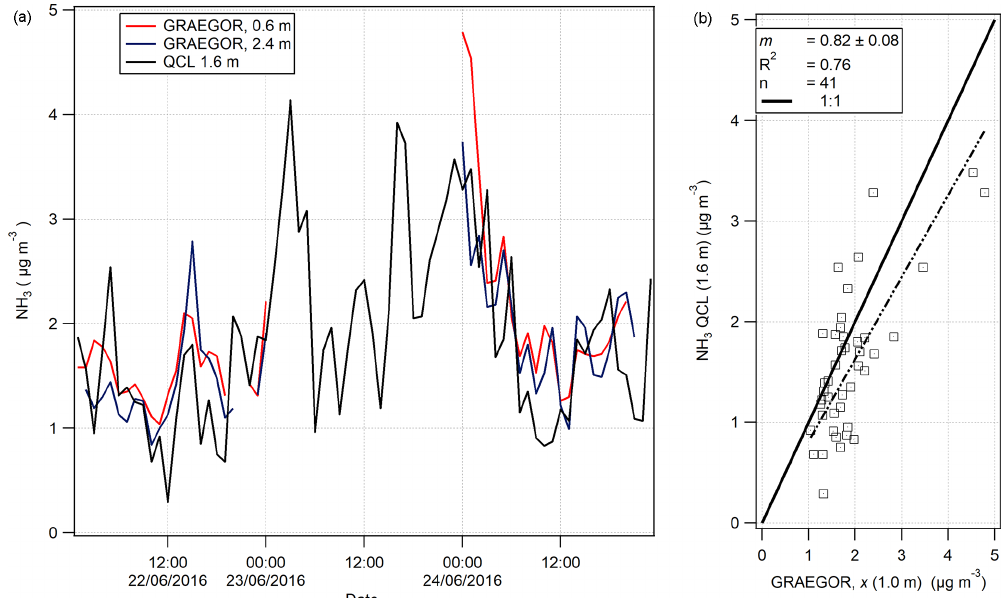
Figure 10. (a) Time series of hourly averages of NH 3 measurements recorded by GRAEGOR (0.6 and 2.4m) and QCL. (b) Linear regression analysis between QCL NH 3 measurements and GRAEGOR (derived averaged concentration at 1.0m) NH 3